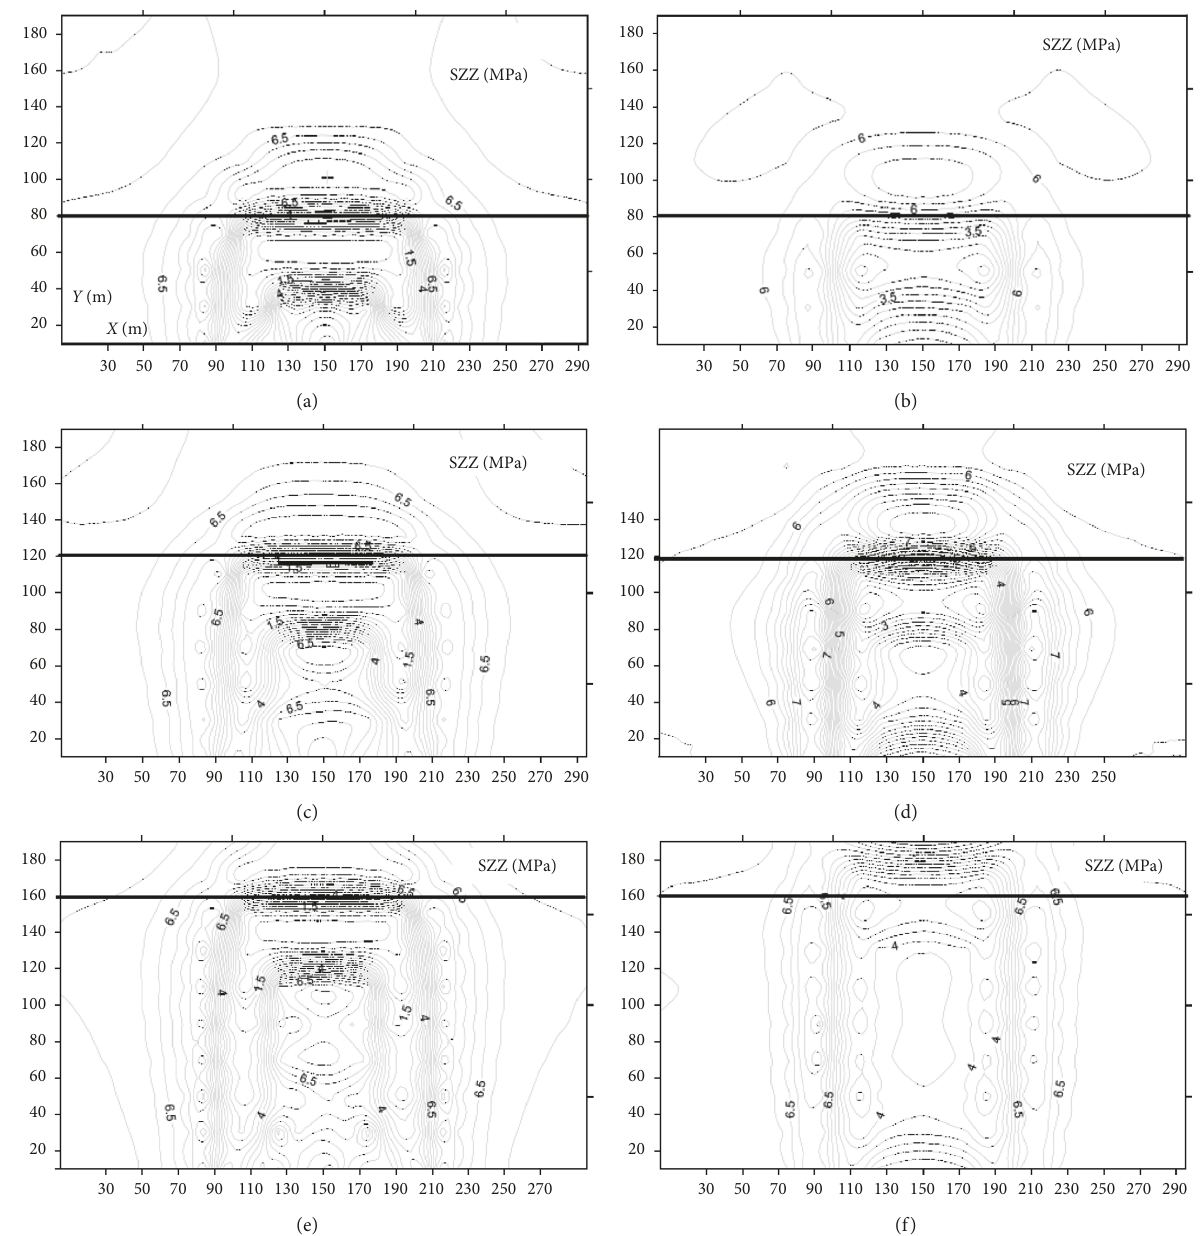
Figure 9: Vertical stress of the floor at different advance distances: 80m mining advance by (a) caving and (b) backfilling; 120m mining advance by (c) caving and (d) backfilling; and 160m mining advance by (e) caving and (f) backfilling.